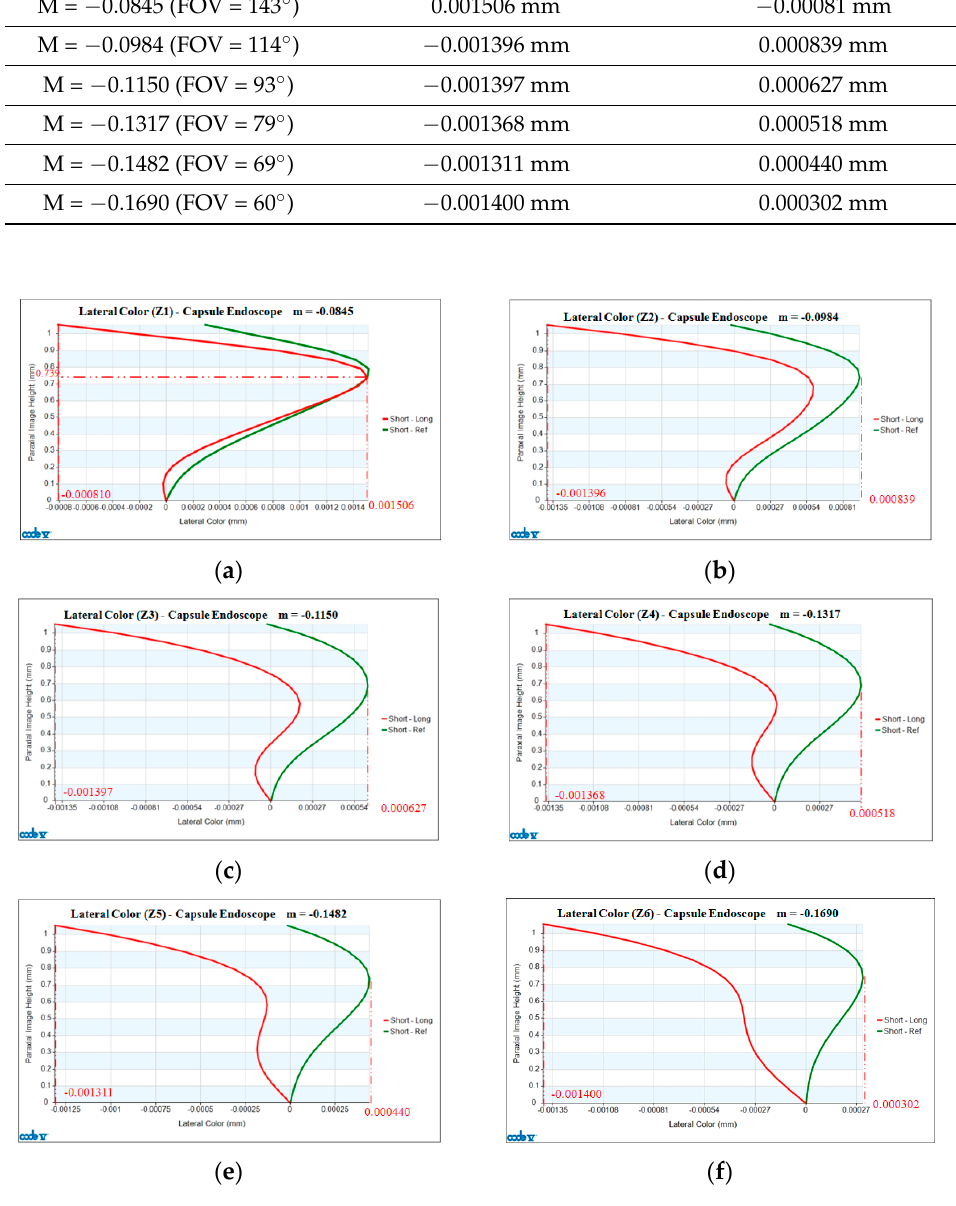
Figure 6. Lateral color curves of a 2× zoom lens at different magnifications: ( a )M = − 0.0845; ( b ) M = − 0.0984; ( c ) M = − 0.1150; ( d ) M= − 0.1317; ( e ) M = − 0.1482; ( f ) M= − 0.1690.